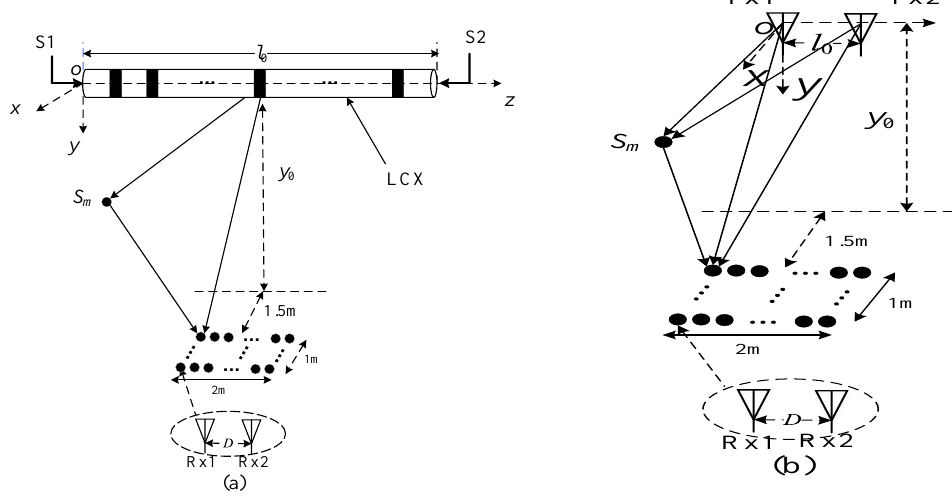
Figure 13. MIMO system: ( a ) transmitting antenna and receiving antenna are LCX and dipole antennas, respectively; ( b ) transmitting antenna and receiving antenna are both dipole antennas.